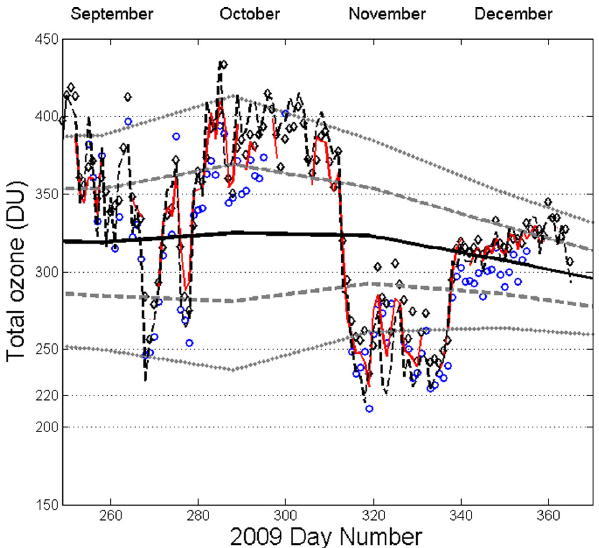
Fig. 1. 2009 daily evolution of total ozone column at R´ıo Gallegos measured with Brewer 124 spectrophotometer (blue open circles), SAOZ spectrometer (black open diamonds), and OMI satellite mea- surements (red line). The SAOZ data corresponds to mean sunrise and sunset values. Total ozone column at Punta Arenas measured with Brewer SN 180 is shown as a dashed black line. Data span from the middle of September to the end of December. Climato- logical MSR monthly mean total ozone column for R´ıo Gallegos site (1978–2008) (black solid line) ± 1SD (dashed gray lines) and ± 2SD (dotted gray line) are also